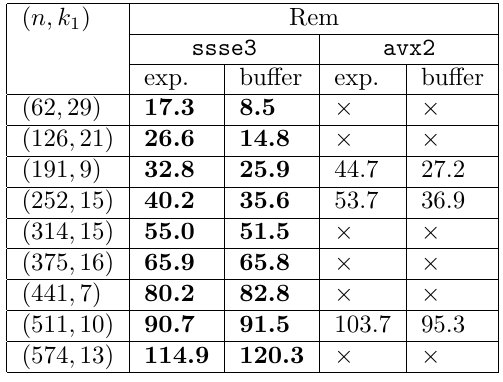
Table 8: Number of cycles to compute the multiplication in F 2 n in function of the modular reduction, with MQsoft . We use a Skylake processor (LaptopS).